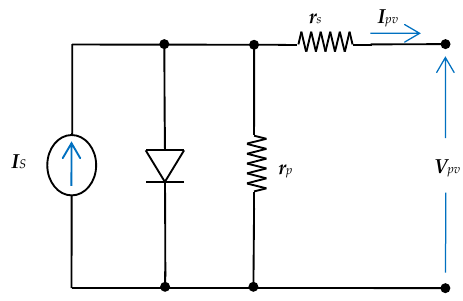
Figure 2. The equivalent circuit model of the PV panel.